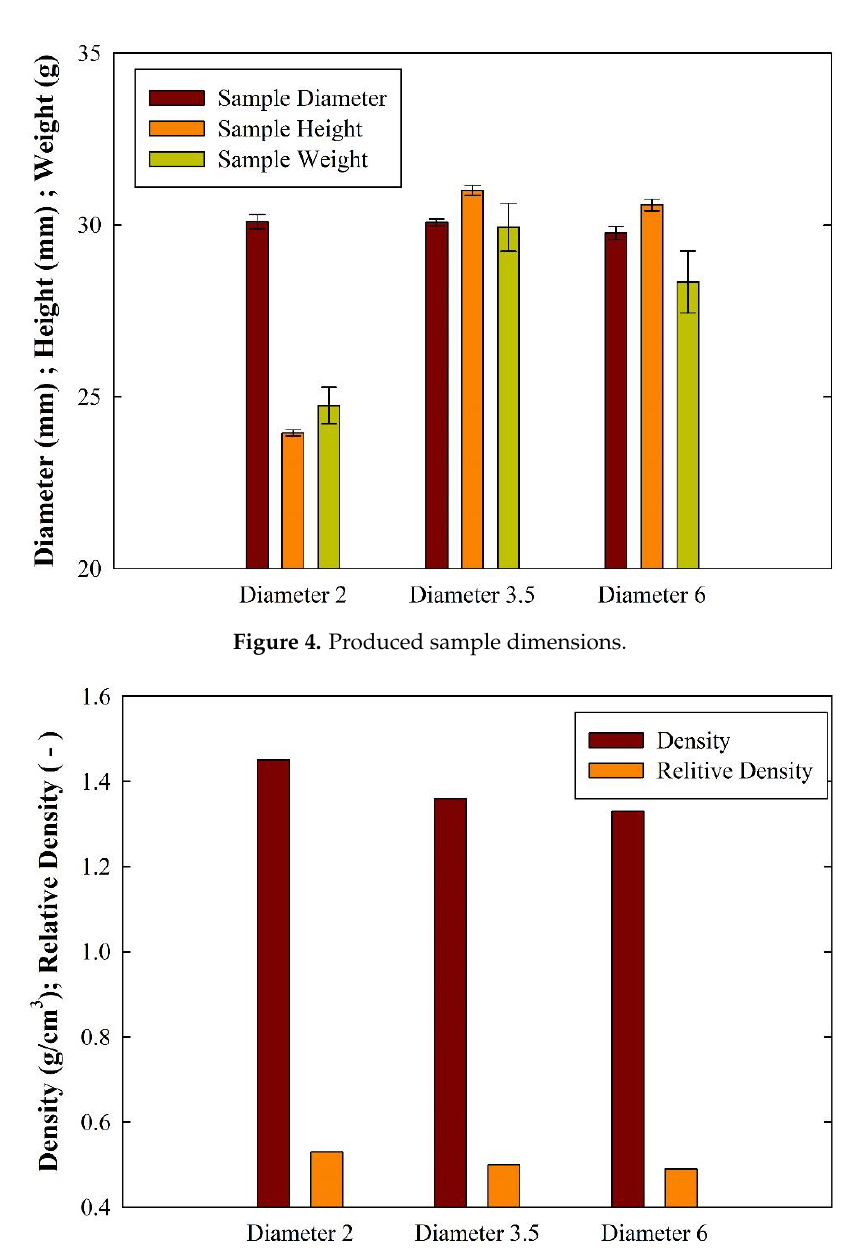
Figure 5. Produced sample densities.